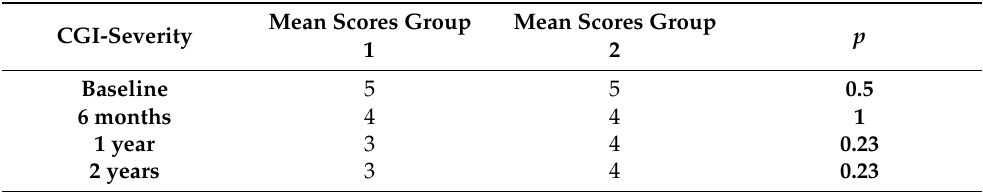
Table 4. Comparative analysis between group 1 with psychostimulants and group 2, concerning the Clinical Global Impression Severity (CGI-S) scale scores, in different time points.